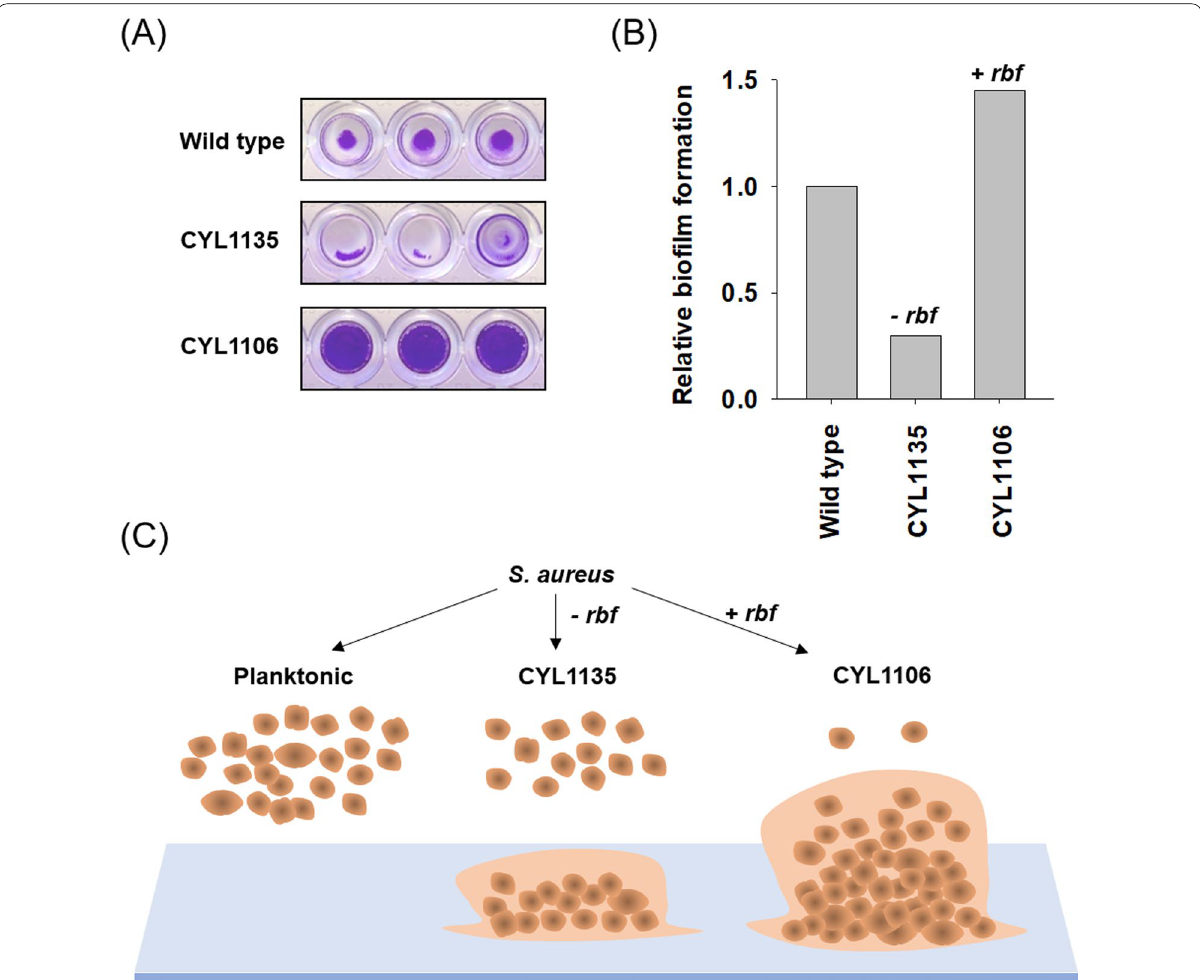
Fig. 2 Effect of the rbf gene on S. aureus biofilm formation. A Wild type, CYL1135, and CYL1106 strains were tested for polystyrene binding in wells of a microtiter plate. The biofilm formed was stained with crystal violet. B Biofilm formation of wild type, CYL1135, and CYL1106. The absorbance was determined at 590 nm. The results represent the averages of three independent experiments. C Schematic representation of planktonic S. aureus , low biofilm‑forming CYL1135, and high biofilm‑forming